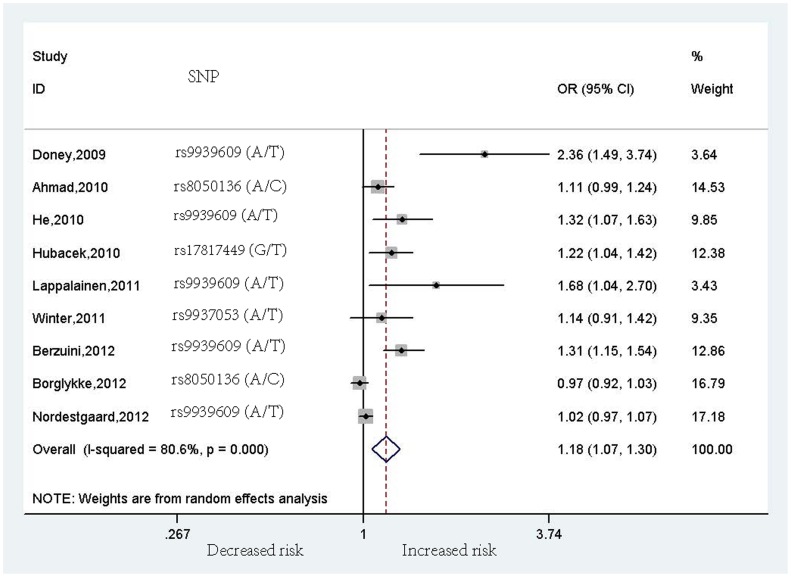
Meta-analysis of the association between rs9939609 (or its proxies) polymorphism in the FTO gene and cardiovascular disease risk.OR is reported to increased CVD risk; weights are calculated from the inverse of their variance.